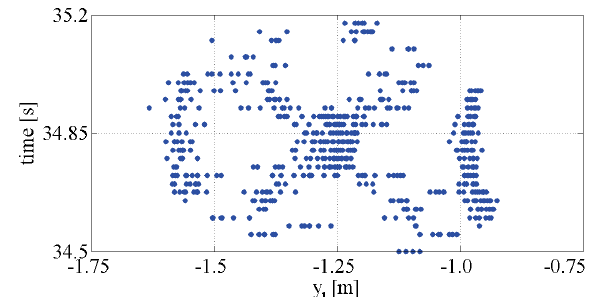
Figure 13: Detected UAV during flight through laser scanner plane, plotted against